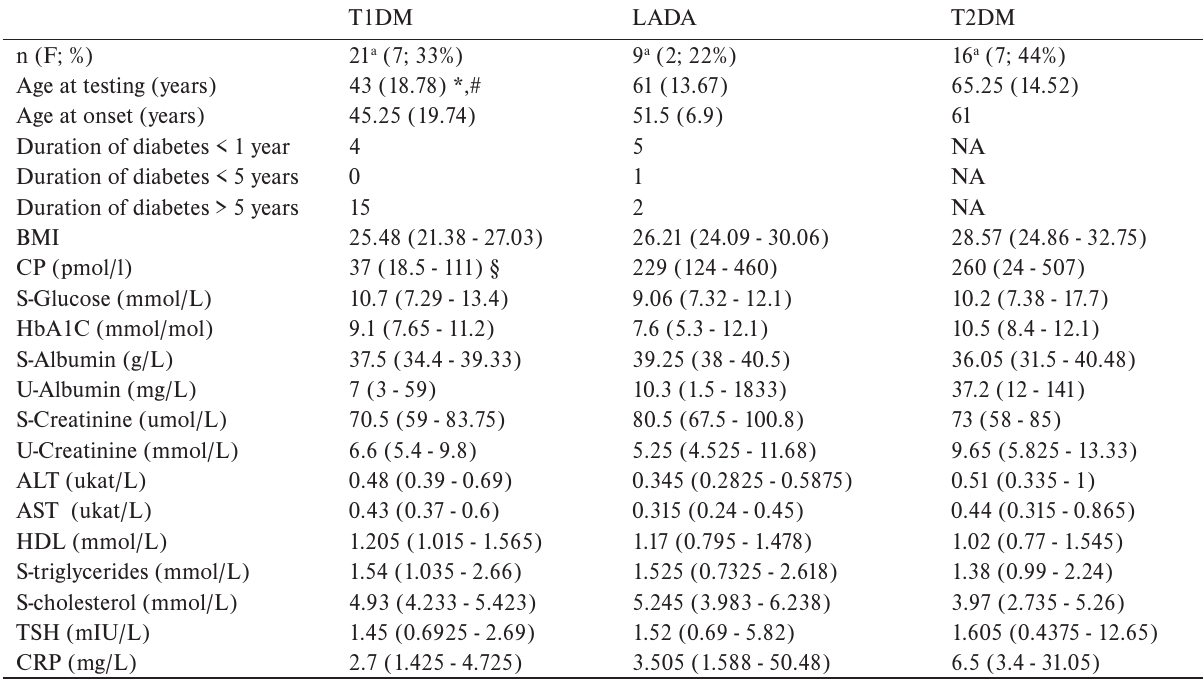
Table 1. Clinical and biochemical characteristics of